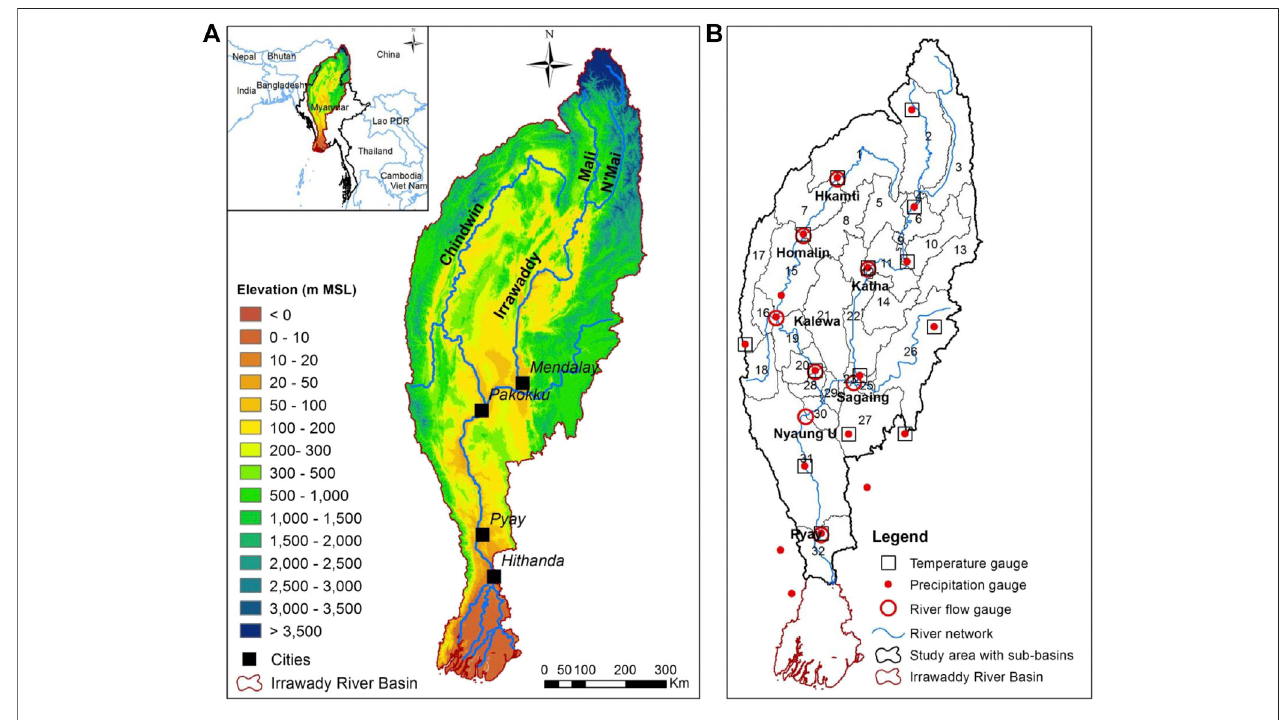
FIGURE 1 | Irrawaddy River Basin in Myanmar (A) , and sub-basin and hydro-meteorological station distribution within the study area (B) .